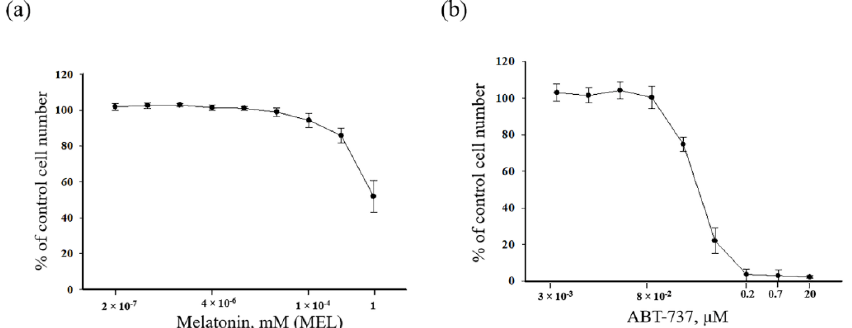
Figure 1. Concentration dependence of the cytotoxic e ff ects of melatonin (MEL) and ABT-737. Cells were seeded in a 96-well plate at a density of 5 × 10 3 cells per well and treated with indicated concentrations of ( a ) MEL and ( b ) ABT-737 for 24 h. The data are presented as means ± S.D. of ten separate experiments.